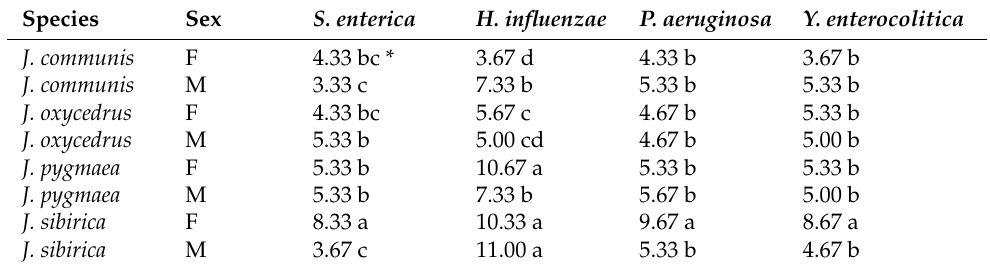
Table 10. Mean antimicrobial activity (inhibition zones in mm) of S. enterica , H. influenzae , P. aeruginosa , Y. enterocolitica , and S. pneumoniae obtained from the eight combinations of species and